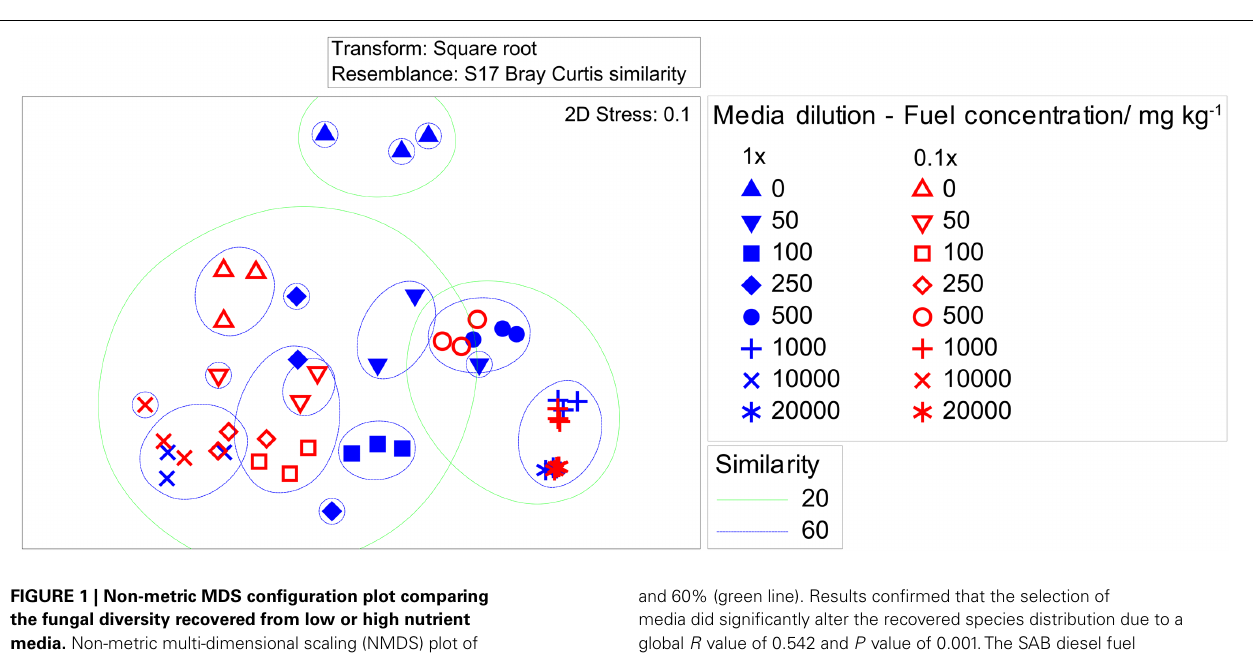
and 60% (green line). Results confirmed that the selection of media did significantly alter the recovered species distribution due to a global R value of 0.542 and P value of 0.001.The SAB diesel fuel concentration within spiked soil samples resulted in an even greater effect on recovered species distribution as revealed by a global R value of 0.916 and P value of 0.001.